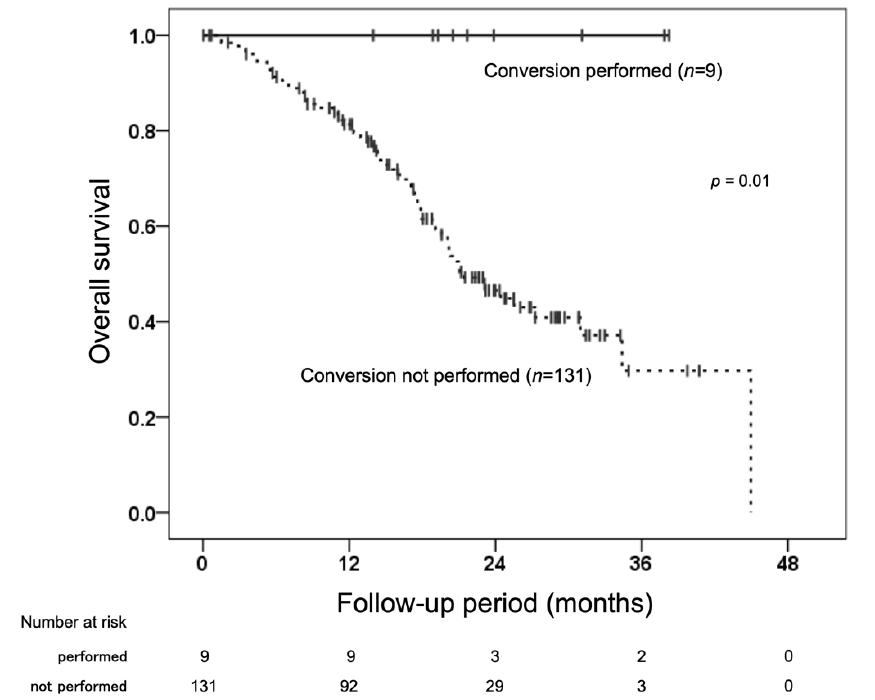
Figure 4. Comparison of overall survival (OS) by conversion